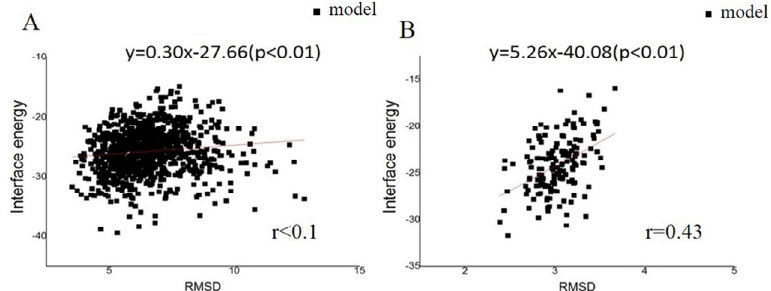
Figure 1. The landscape of interface energy score for the GC pili. The black dots stand for the distribution of RMSDs of the models. The red lines and formulae indicate the correlation between RMSD and energy. The results from: ( A ) the whole model set; and ( B ) the largest cluster.